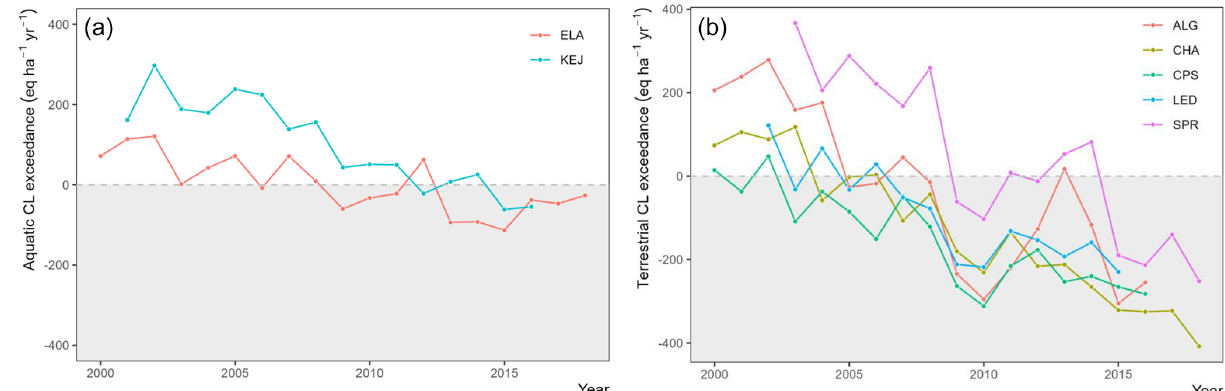
Figure 11. Critical load (CL) exceedances from total sulfur and nitrogen deposition near selected CAPMoN stations at Algoma (ALG), Chalk River (CHA), Chapais (CPS), Experimental Lakes Area (ELA), Lac Edouard (LED), Kejimkujik National Park (KEJ), and Sprucedale (SPR) for lakes (a) and soils (b) . Stations with deposition fluxes below CL in every year from 2000–2018 are not shown. The gray area represents